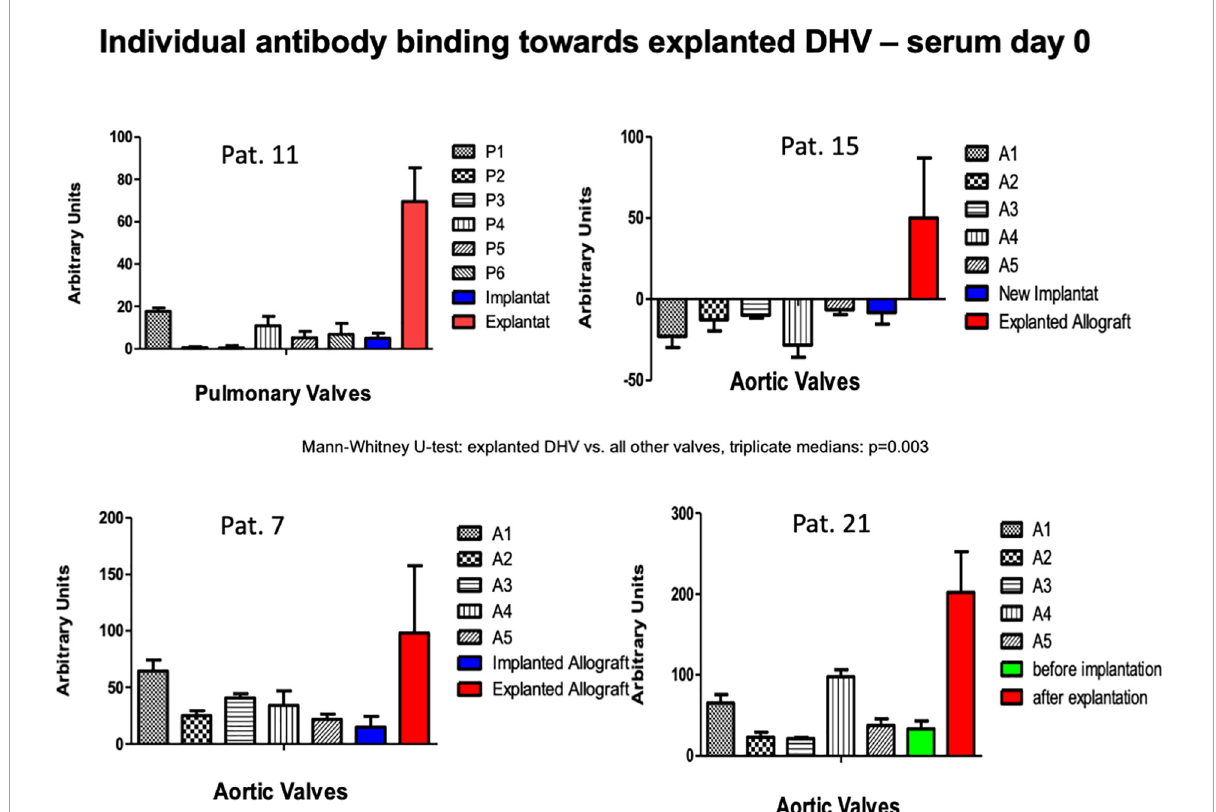
FIGURE5 Antibody binding in patients with previous DHV and with new decellularized allografts replacing the degenerated previously implanted grafts (patients 7, 11, 15). The amount of antibody binding to one DAH retention sample 60 months after implantation and in the explanted degenerated DAH is also shown (patient